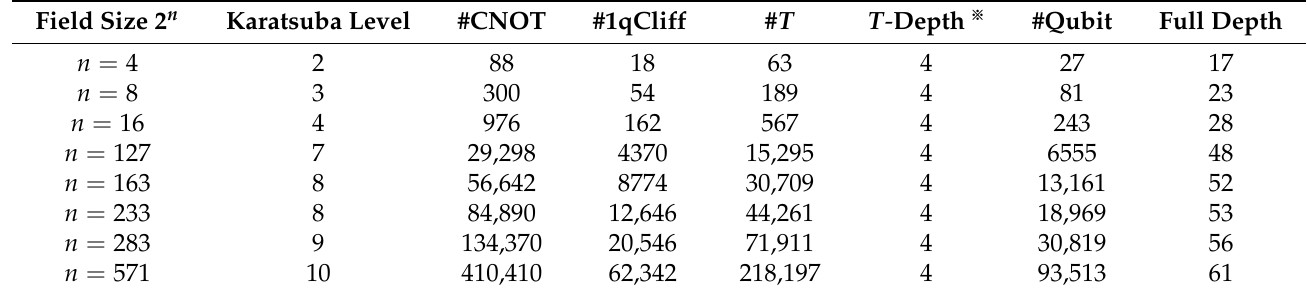
Table 2. Quantum resources needed for multiplication with a Toffoli depth of